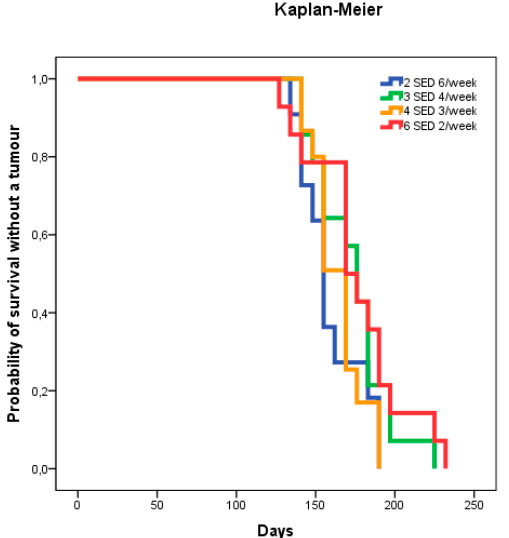
Figure A1. Dose–delivery study: Kaplan–Meier plot showing tumor-free survival (Groups 1–4). There are no differences in time until tumor development between the groups irradiated with 2 SED 6 × /week, 3 SED 4 × /week, 4 SED 3 × /week, or 6 SED 2 × /week (155, 176, 169, and 169 days).